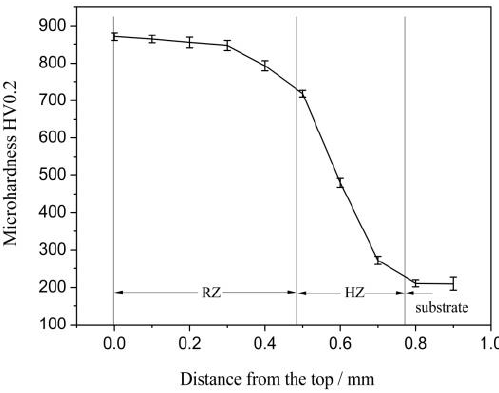
Figure 6. Microhardness distribution along the cross-section of the specimens. It can be seen that the hardness of the M2 proposed in this paper is about 581 HV0.2, which is close to the micro-hardness of the working layer of rolls manufactured by centrifu- gal casting [27]. In addition, an adequate thickness (approximate 0.2 mm) between the M2 position and the substrate was determined to ensure the safety of wear-resistance work- pieces. Therefore, the method of using two-thirds as the surface repair time proposed in this paper was feasible and met the performance requirements of wear-resistant